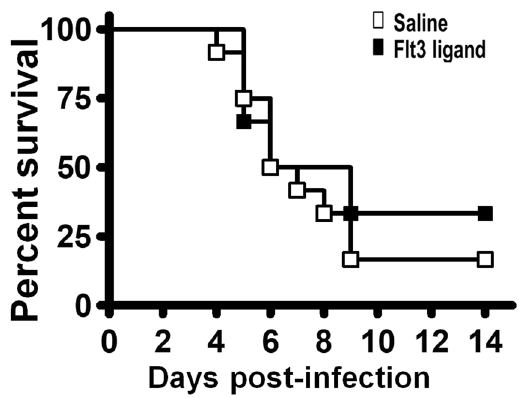
Figure 6. Treatment of mice with Flt3 ligand after infection. The survival rates of infected mice, which were treated with saline ( n = 12) or Flt3 ligand ( n = 6) on days 1–6 post-infection, are